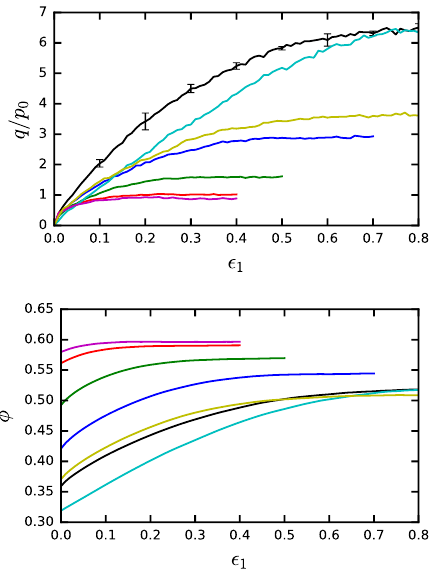
Figure 5. Upper graph: normalised deviator stress q / p 0 , versus axial strain. From top to bottom: P ⇤ = 0 . 1 (black); P ⇤ = 0 . 1, but (only in that case) large initial coordination number (light blue); P ⇤ = 0 . 1, without distant interactions, D R = 0 (yellow); P ⇤ = 0 . 316 (dark blue); P ⇤ = 1 (green); P ⇤ = 6 . 32 (red); P ⇤ = i.e. no cohesion (purple). Error bars extend from the lowest to the highest value obtained in 3 samples. Lower graph: solid fraction  vs. ✏ 1 , same colour code.